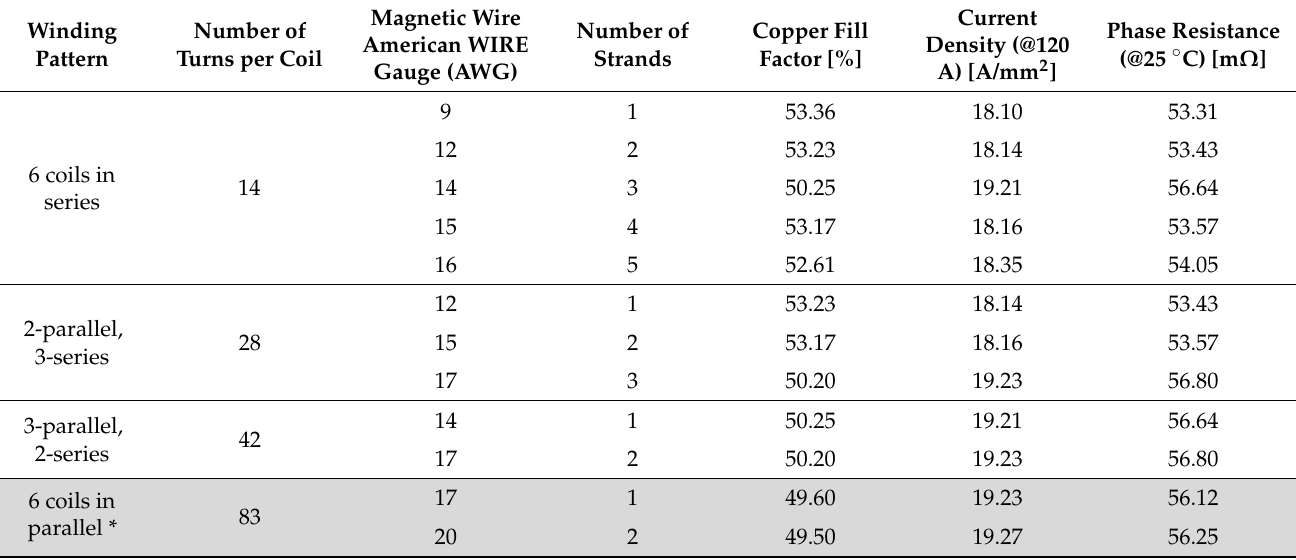
Figure 8. Block diagram showing the operation of the script to determine the coil parameters. Table 3. Coil possibilities for the design.